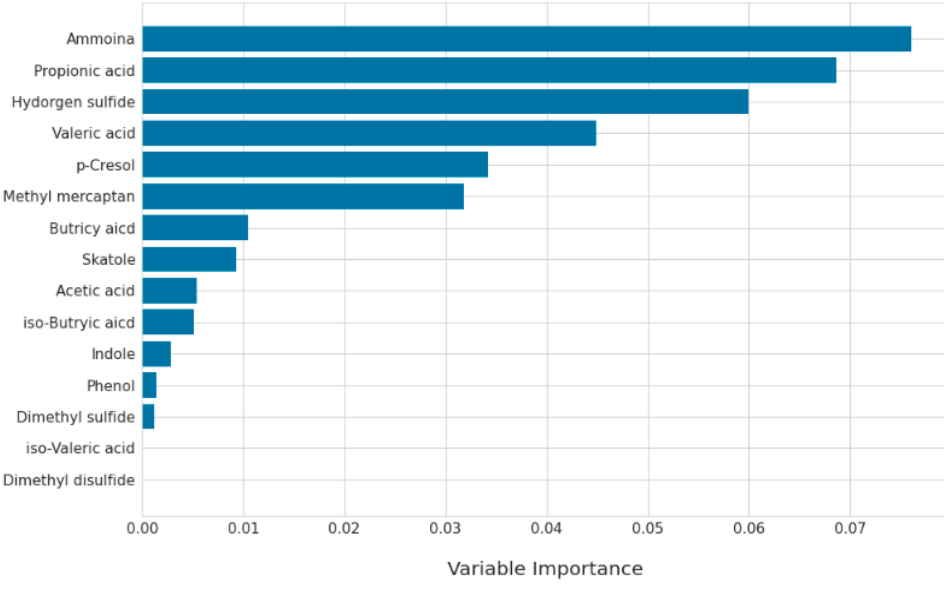
Figure 7. Variable importance of odor